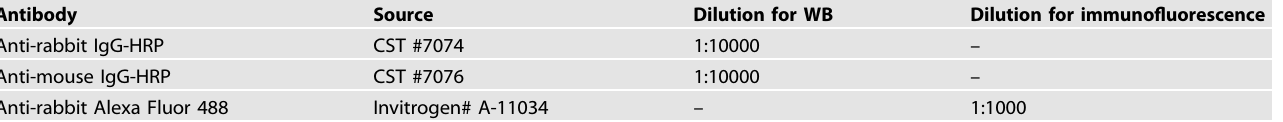
Table 2. List of secondary antibodies.